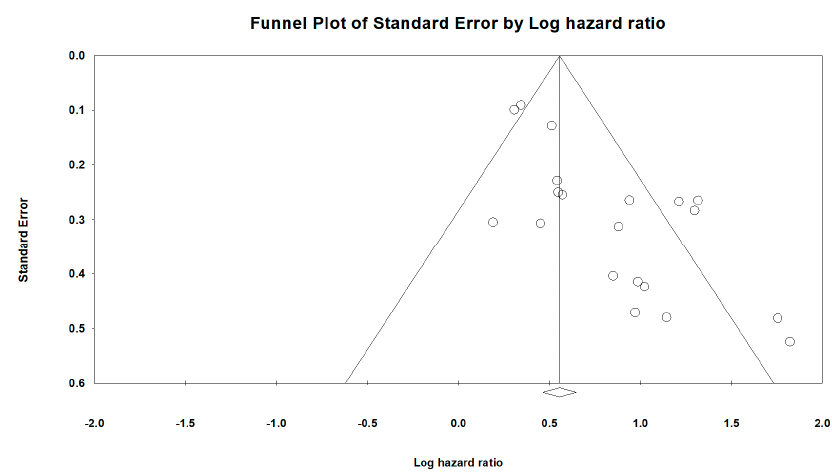
Figure 4. Funnel plots for the included studies in this meta-analysis. Each point represents a separate study. The two sloping lines indicate the 95%